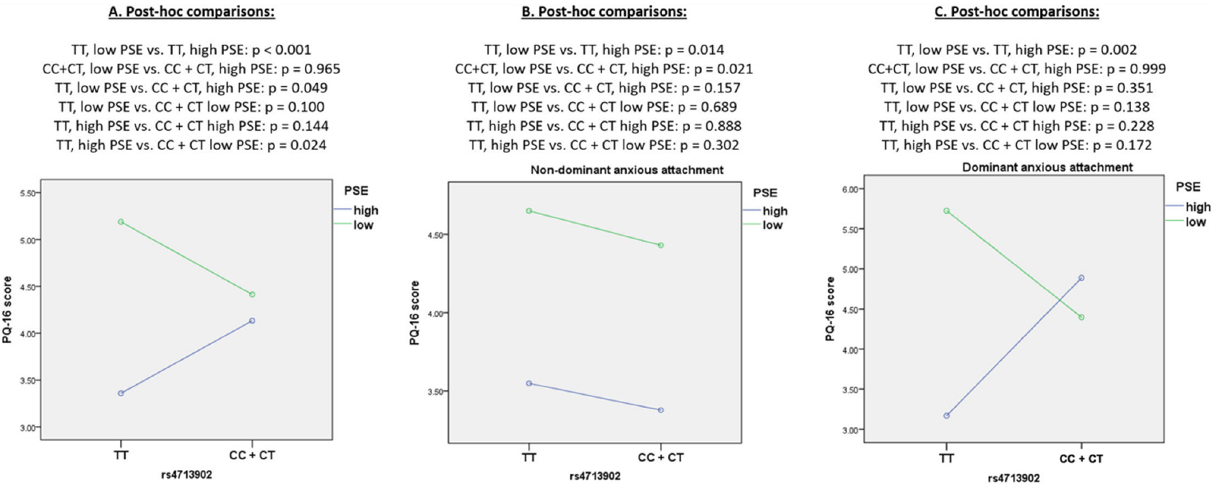
Figure 1. Post-hoc comparisons of interactions between FKBP5 rs4713903 polymorphism total PQ- 16 score and attachment style. Abbreviations: PSE—perceived self-efficacy, PQ-16—Prodromal Questionnaire 16.